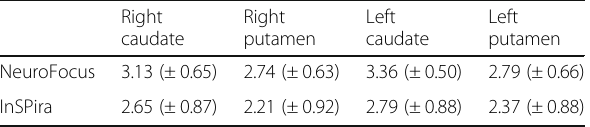
Table 1 Mean specific to non-specific [ 123 I]FP-CIT binding ratios (± SD) in bilateral caudate nucleus and putamen of data obtained on the NeuroFocus and InSPira system in 14 subjects Right